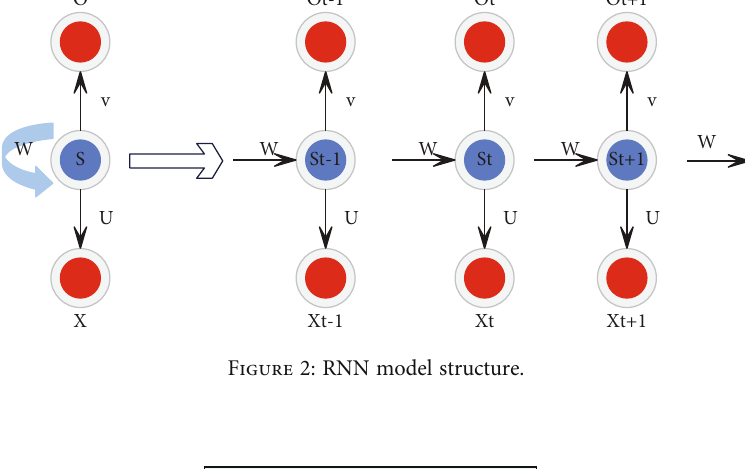
Figure 2: RNN model structure.